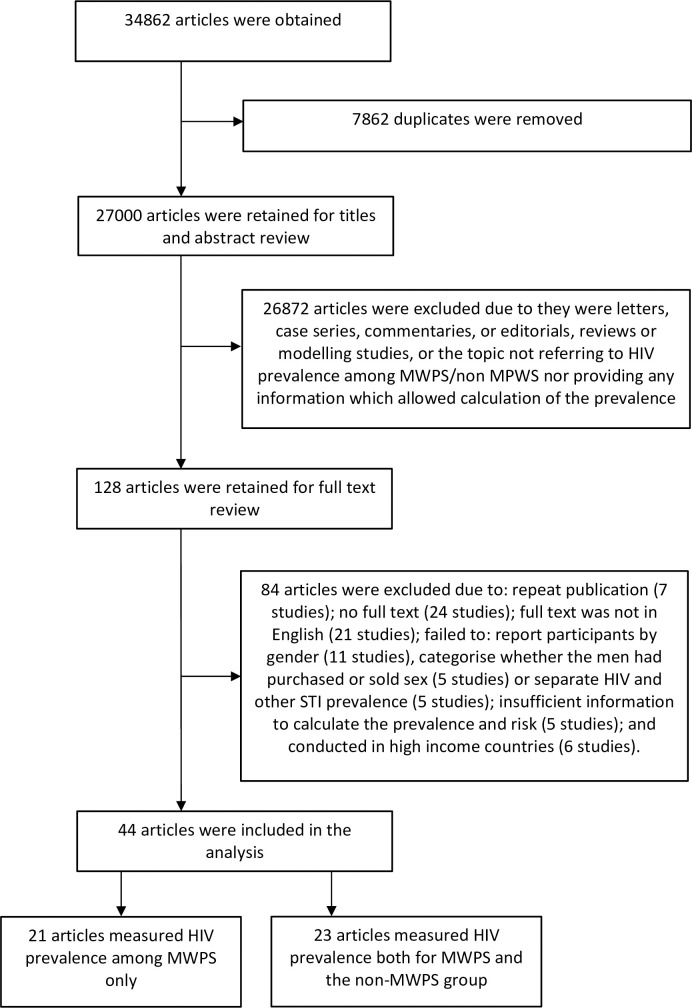
A flow diagram of the search and paper selection process.